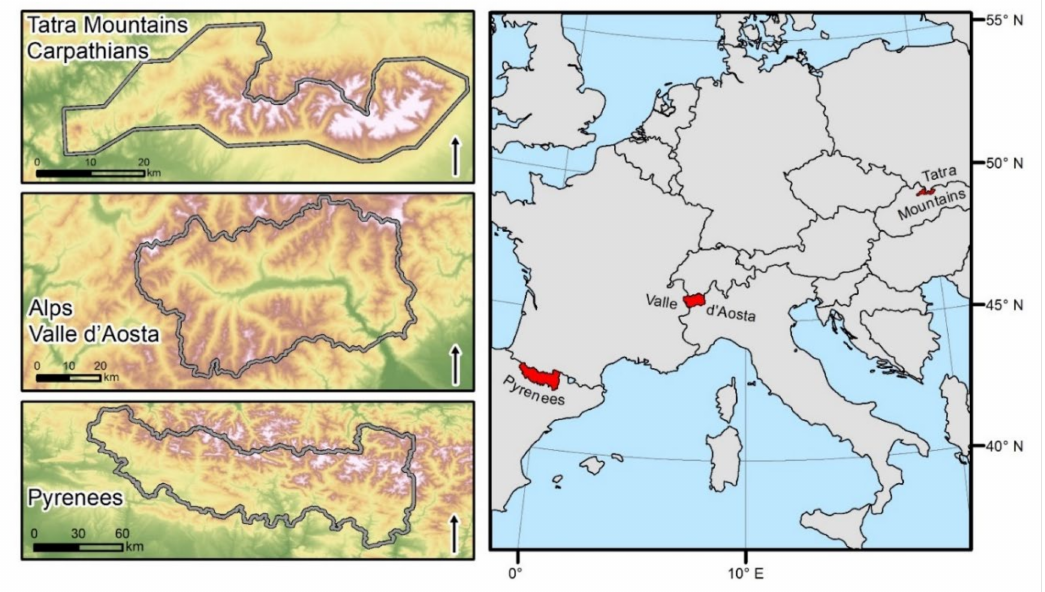
Figure 1. Locations of the three study areas within Europe: the Alps, the Pyrenees, and the Tatra